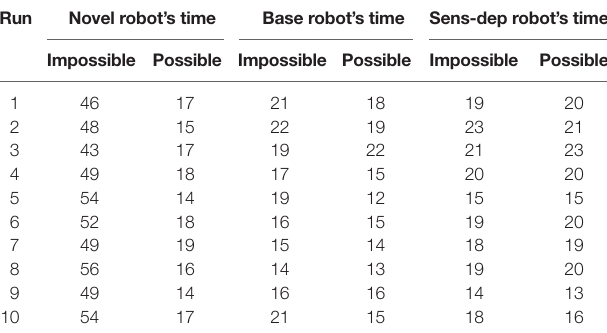
TaBle 4 | results from the VOe experiment showing the time (in seconds) spent focusing on or interacting with the impossible and possible object. run novel robot’s time